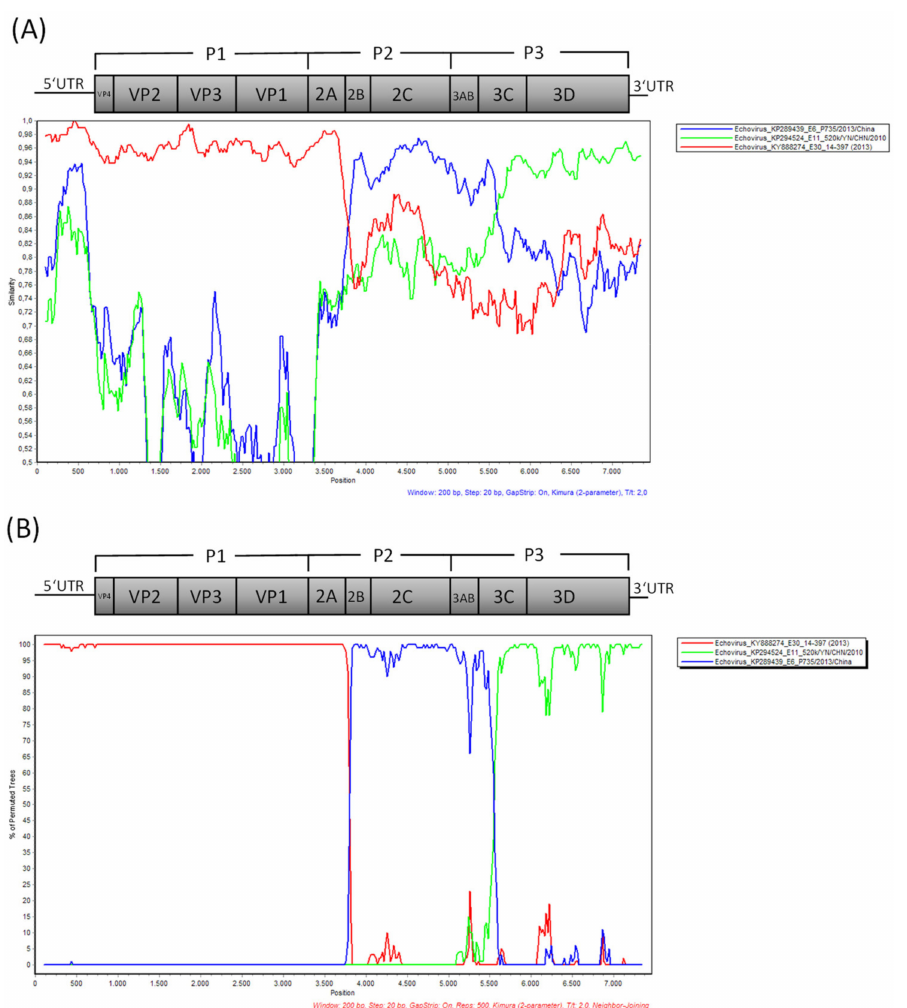
Figure 3. Whole genome Simplot BootScan analysis with the query sequence of strain NZ/Ashburton/17WQ2027G/2017-08-20 (accession number MW586892) compared to Echovirus E6 (accession number KP289439), E11 (accession number KP294524), and E30 (accession number KY888274) reference sequences. ( A ) Similarity plot analysis, ( B ) Bootscanning analysis on the putative recombinant strain and its parental sequences. The enterovirus genomic organization is shown in the